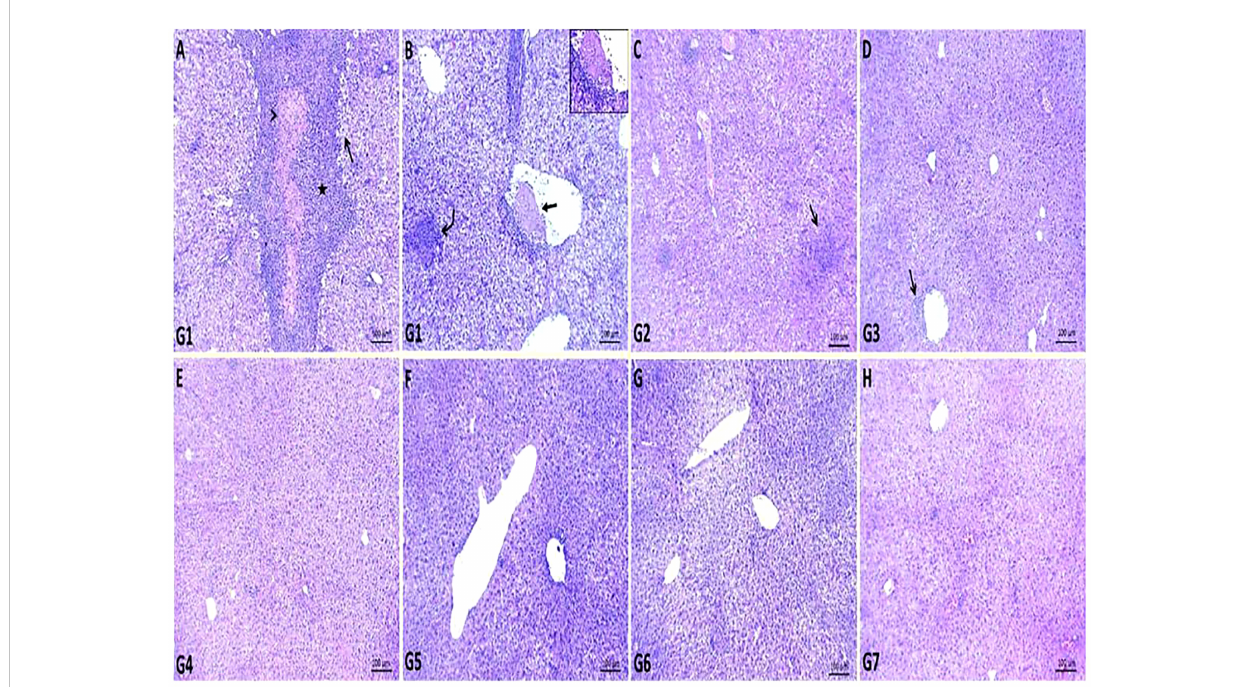
FIGURE 2 Representative photomicrographs of liver sections of different groups in S. aureus mouse model. (A, B) : areas of coagulative necrosis (arrowhead) surrounded by intense in fl ammatory cells in fi ltrates (star), focal area of microabscess (curved arrow), areas of steatosis (open arrow) and presence of attached thrombus within some hepatic blood vessel (closed arrow) in control positive group (G1), (C) : replacement of focal areas of hepatic parenchyma by leukocytic in fi ltrates (arrow) in gentamicin-treated group (G2), (D) : presence of few perivascular in fl ammatory cells in fi ltrations (arrow) in ursolic acid methyl ester - treated group (G3), (E) : normal histology of hepatic parenchyma and blood vessels in saline control negative group (G4), (F) : normal histomorphological structures of hepatic cords and central veins in tween-20 control negative group (G5), (G) : normal cytoarchitectures of hepatic cells and central veins in ursolic acid methyl ester control negative group (G6), (H) : relatively normal hepatocytes and hepatic vasculatures in gentamicin control negative group (G7). H&E, scale bar 100 m